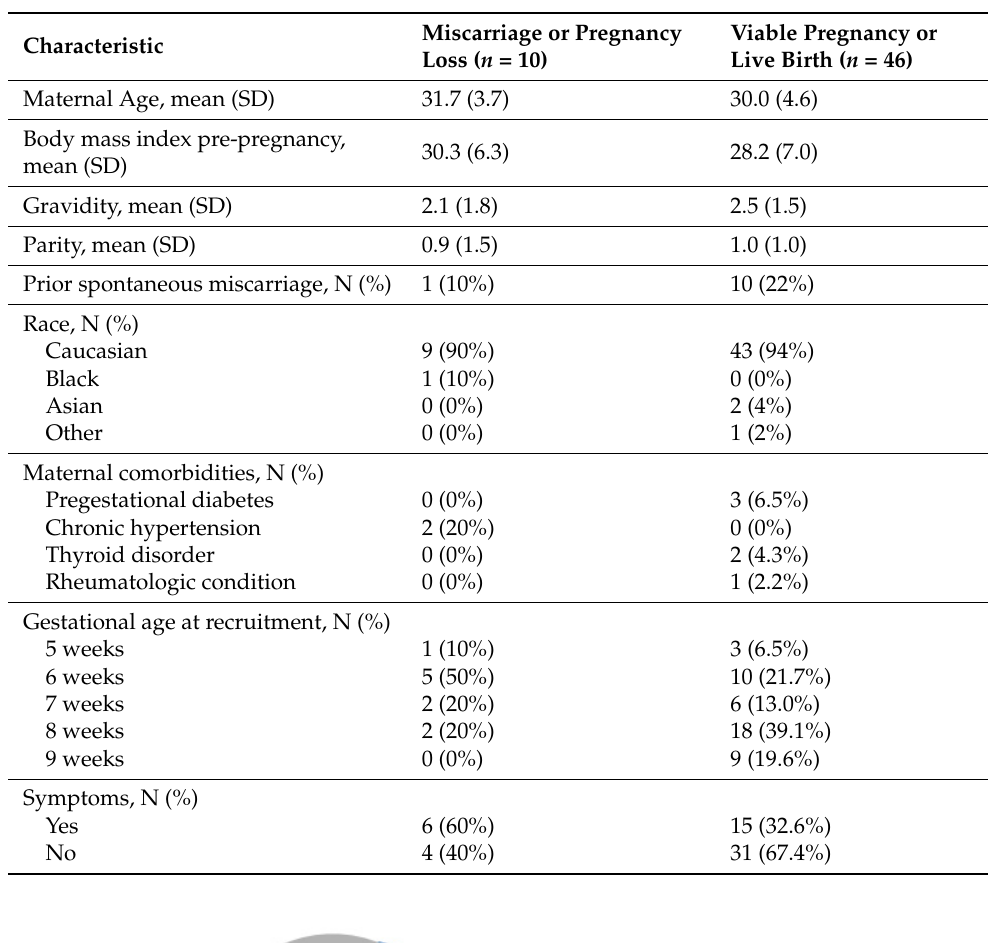
Table 1. Maternal and obstetric characteristics in women with pregnancy loss compared to women who had live birth or viable pregnancy at 20 weeks gestation.